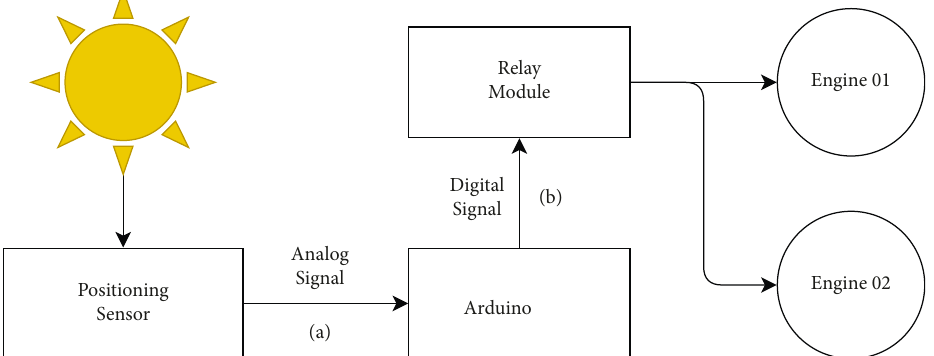
Positioning Sensor Figure 5: Flowchart of the operation of the solar tracking system.